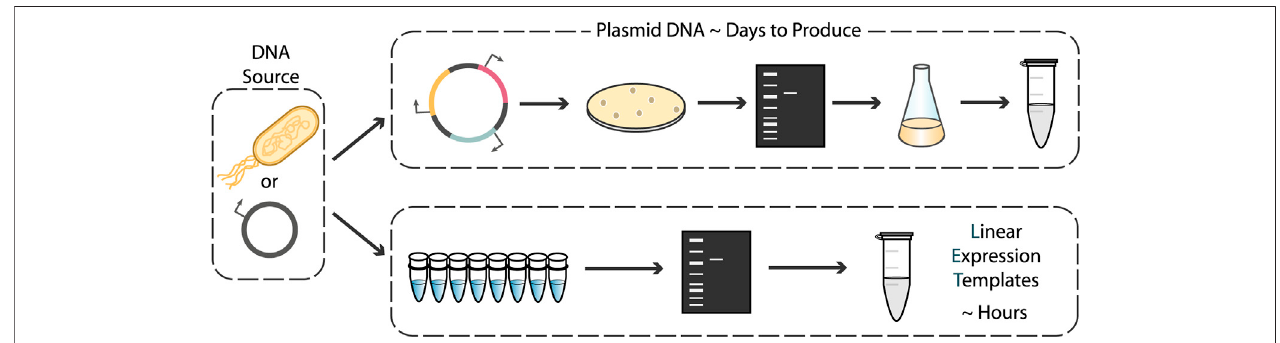
FIGURE 1 | Strategies for preparing DNA templates for use in cell-free expression systems. Traditional plasmid cloning protocols involving construct assembly, transformation, screening, and plasmid puri fi cation take days to complete. Linear expression templates can be made via PCR from genomic DNA or plasmid templates and used directly after amplicon veri fi cation and puri fi cation, drastically reducing DNA template preparation